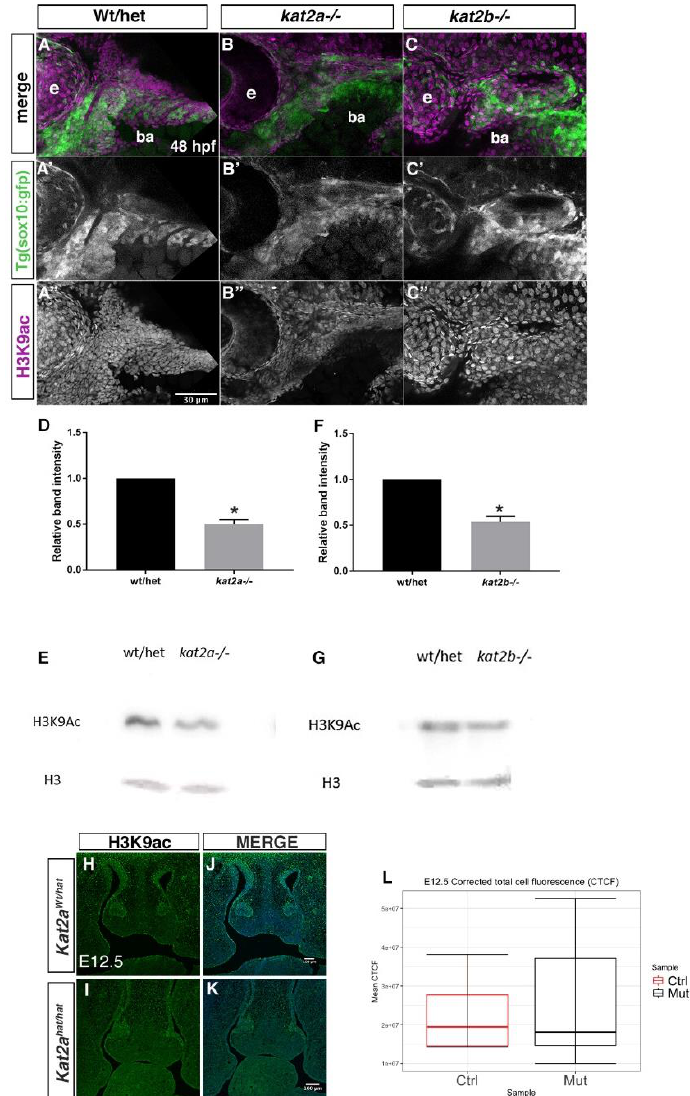
Figure 5. Histone H3 lysine 9 acetylation (H3K9Ac), an active transcription mark, is reduced in kat2a − / − and kat2b − / − zebrafish. ( A – C ”) Maximum projection confocal micrographs of 48 hpf zebrafish embryos labeled to detect H3K9Ac immunofluorescence ( A ”– C ”, magenta in A – C ) and neural crest cells expressing transgenic sox10 :GFP ( A (cid:48) – C (cid:48) , green in A – C ). Lateral views with the anterior to the